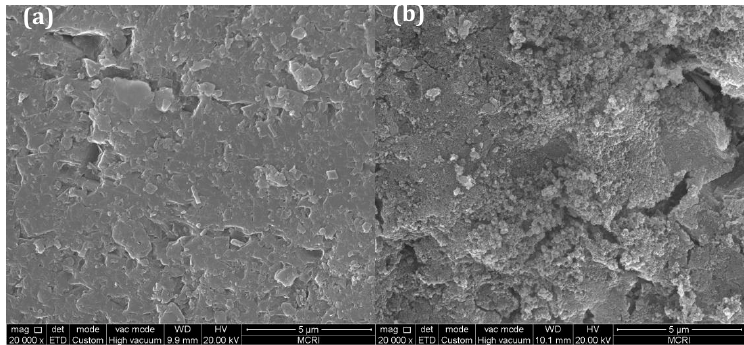
Figure 9. Scanning electronic microscope images of ( a ) virgin sand and ( b ) the filter media collected from filter R3 on the 12th day.